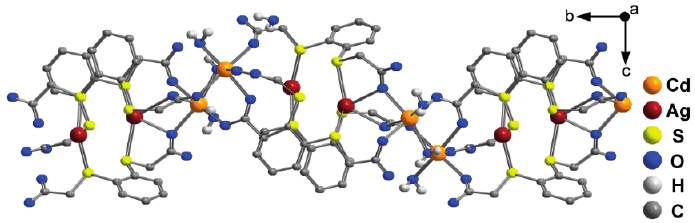
Figure 4. Two-dimensional layered structure of 2 , viewed along the a axis.